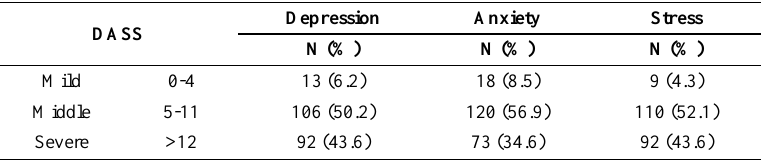
Table 3. Frequency of depression, anxiety and stress